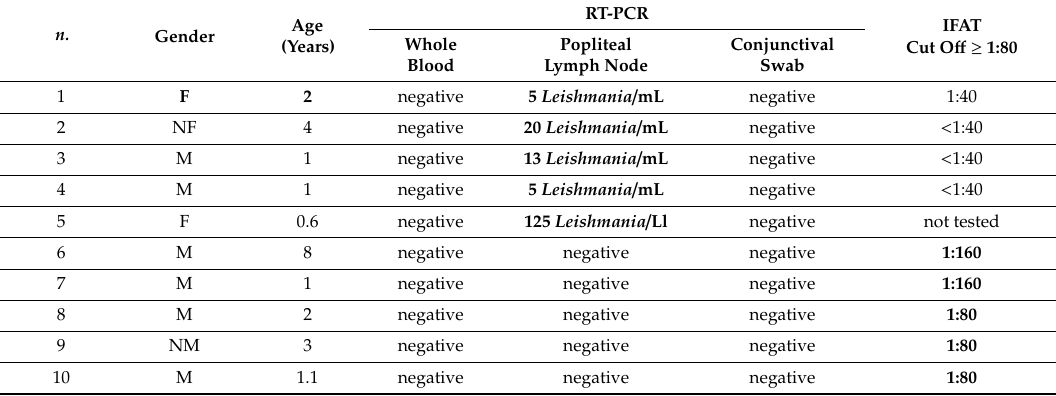
Signalment and results of real-time polymerase chain reaction (RT-PCR) and immunofluorescence antibody test (IFAT) for L. infantum in the 10 infected domestic shorthair cat (DSH) stray